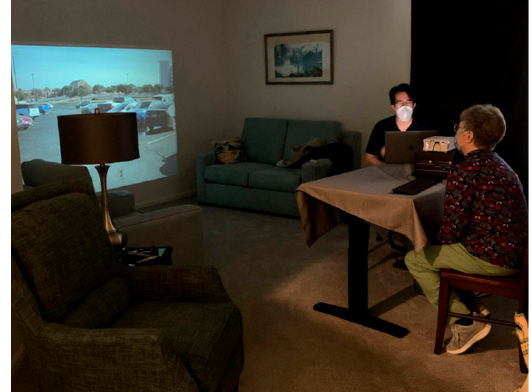
Figure 8. Experiment room in Freedom Village Senior Living Center.